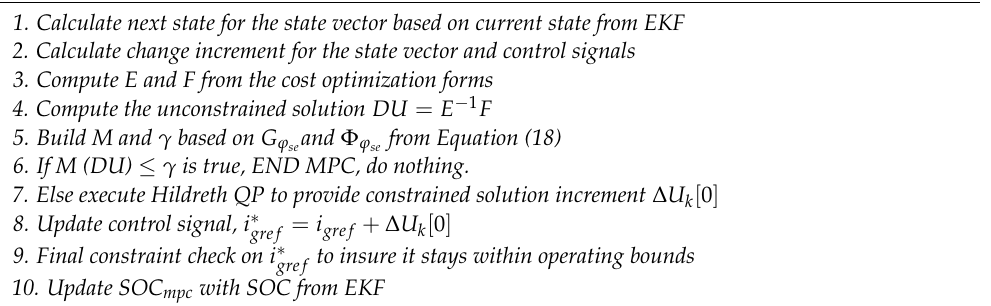
Algorithm 9: Functional Flow of Physics-Based Model Predictive Control